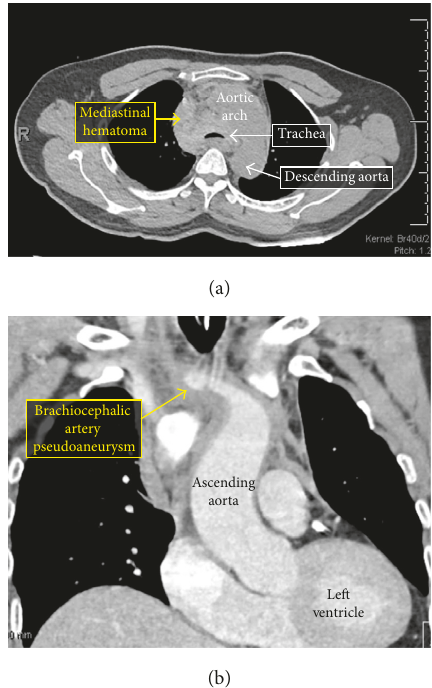
Figure 3: Computed tomography (CT) of the chest without intra- venous contrast demonstrating a hyperdense region surrounding the trachea suggestive of an anterior mediastinal hematoma (a). Computed tomography (CT) of the chest with intravenous contrast demonstrating a small pseudoaneurysm arising from the inferior aspect of the bra- chiocephalic artery